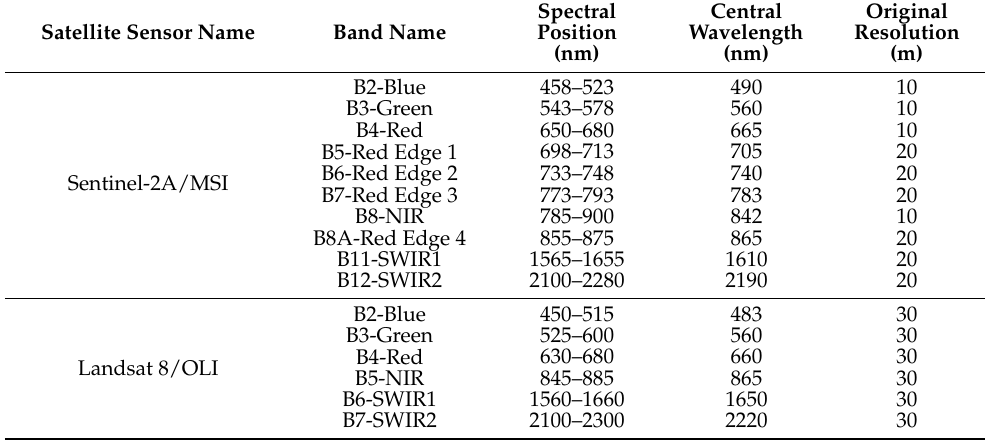
Table 1. Landsat 8 and Sentinel-2A data band